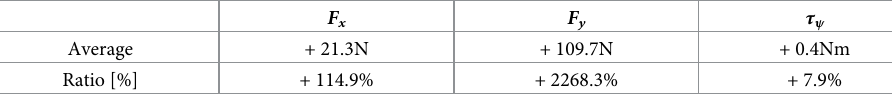
Table 10. Average difference thrust force and torque between fixed weight and algorithm